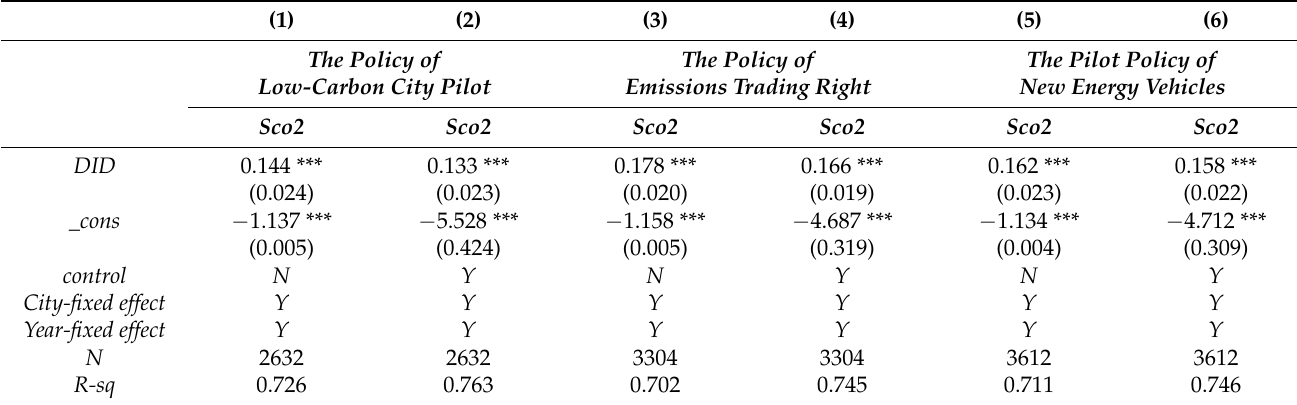
Table 5. Excluding other